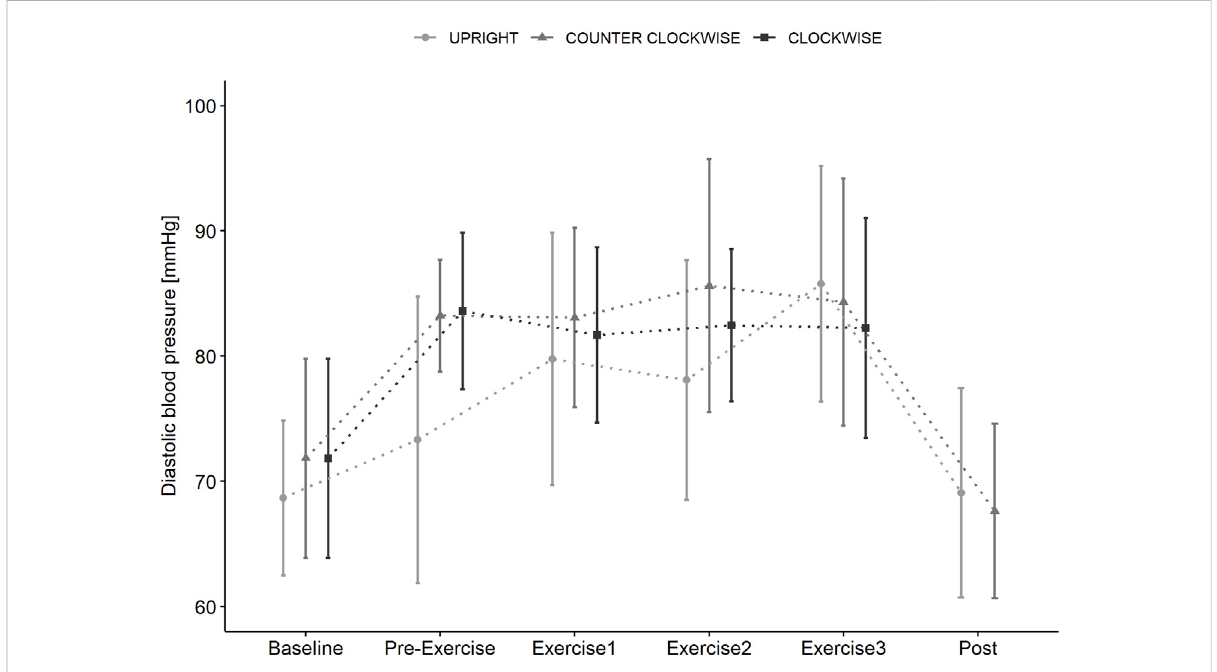
FIGURE 6 Diastolic blood pressure measured in supine position (BASELINE) prior to standing (PRE-EXERCISE) in the UPRIGHT condition, and when rotating passively (PRE-EXERCISE) clockwise (CLOCKWISE) and counter-clockwise (COUNTER-CLOCKWISE) with 1 g at the participants center of massinadditiontodirectlyfollowingContra-lateral,WoodChopper andCrunchexercise(BREAK1,BREAK2,BREAK3)anduponcompletion(POST) of each condition. Data as mean (±SD).